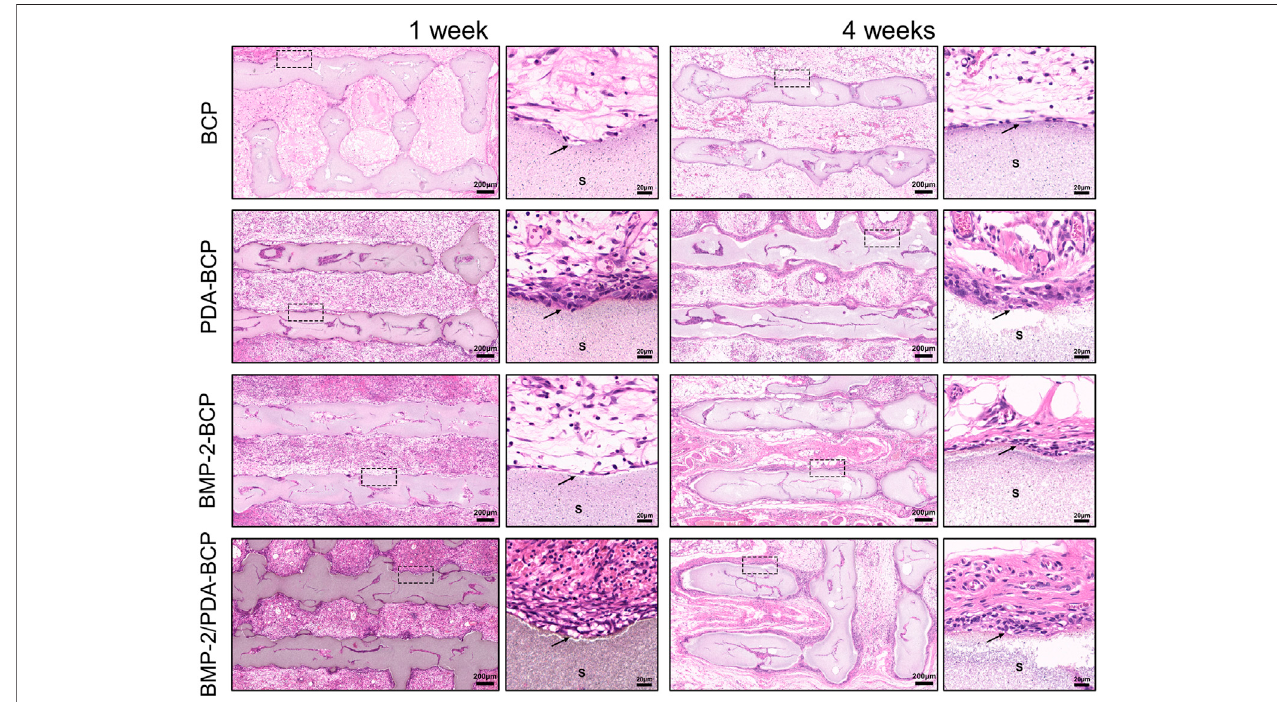
FIGURE 6 | Histological evaluation of the precursor cells in fi ltration in the ectopic osteogenes model of SD rats after 1 and 4 weeks. Original magni fi cation ×50, ×500; scale bar = 200 μ m, 20 μ m. Black arrows: cell adhesion layer, S: scaffolds.